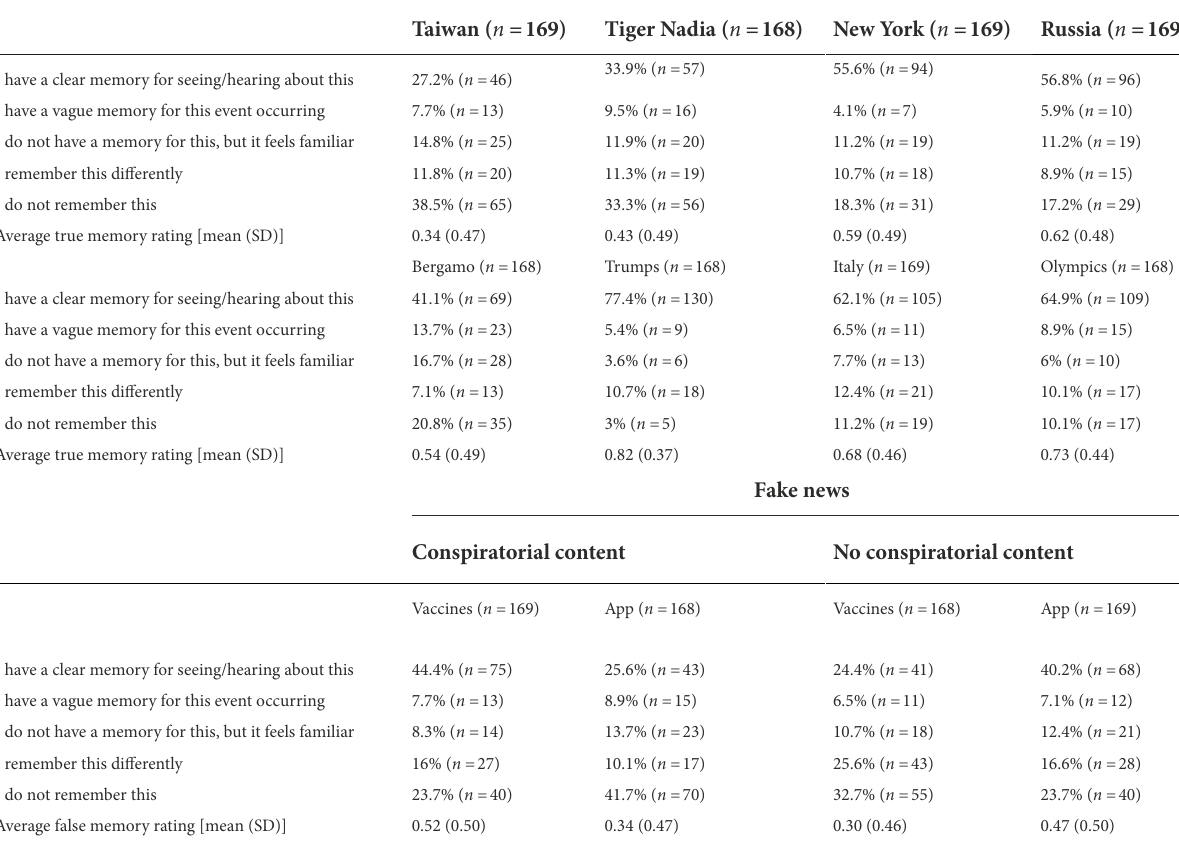
TABLE 3 Participants’ responses to true and fake news (Experiment 2).